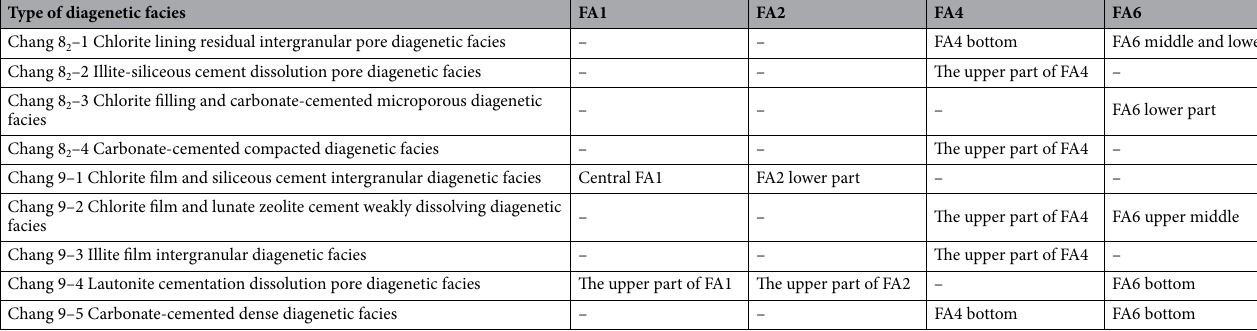
Table 8. The main positions of different types of diagenetic facies in the architectural